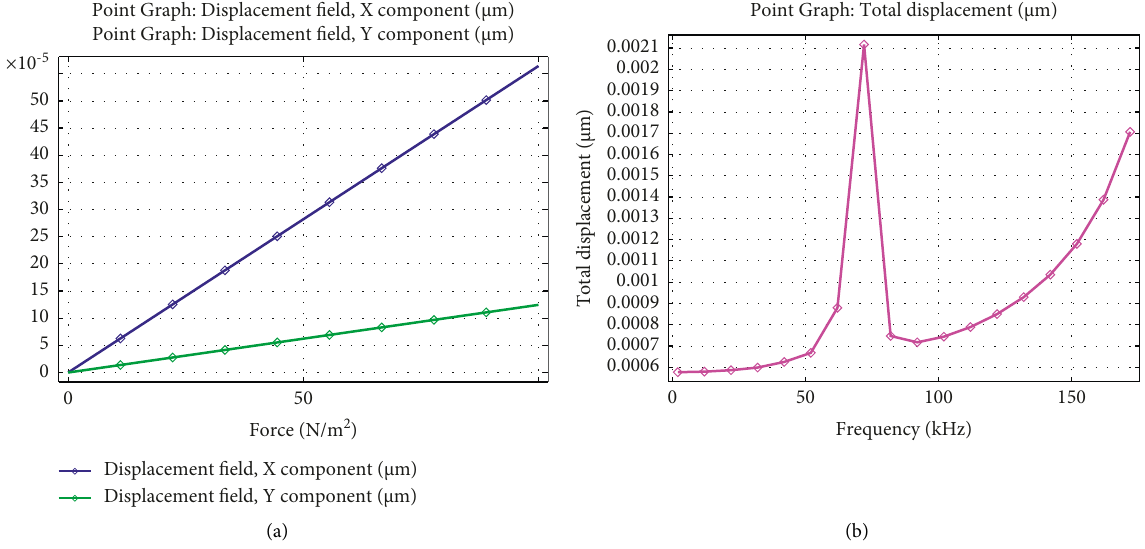
Figure 7: (a) Displacement characteristics; (b) natural frequency for the proposed sensor 1.